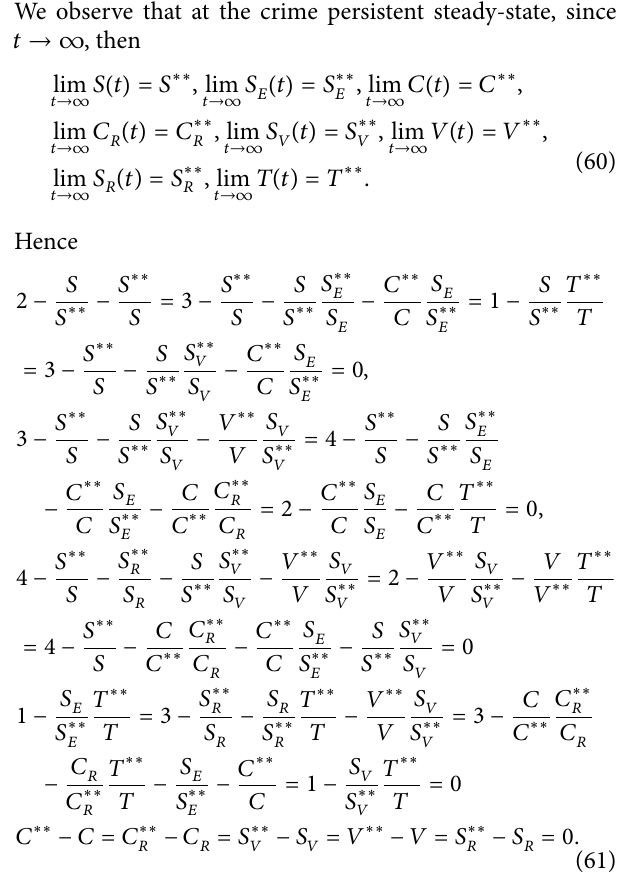
, is GAS when R 1